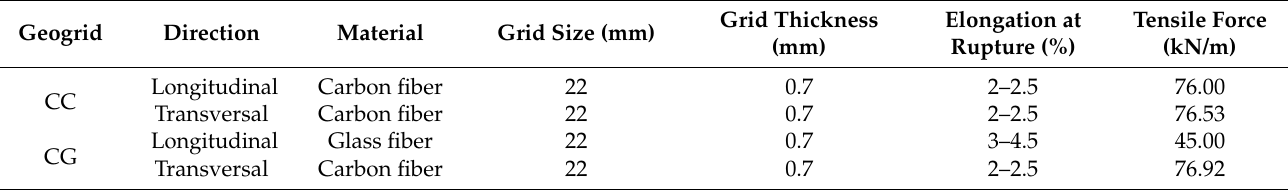
Table 1. Characteristics of CC and CG